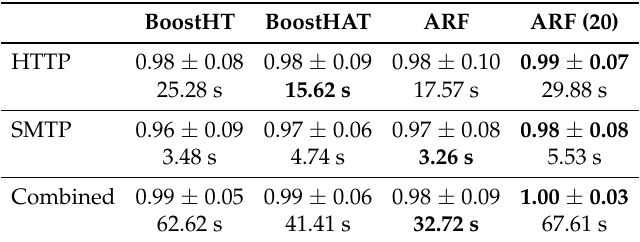
Table 2. Homogeneous ensembles.